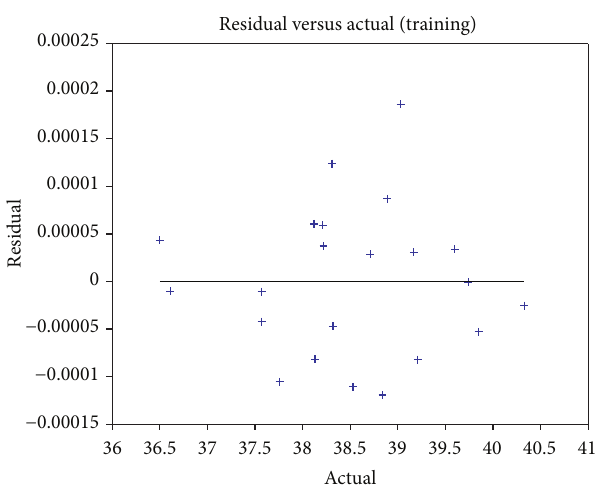
Figure 3: Comparison between residual values and actual values during training